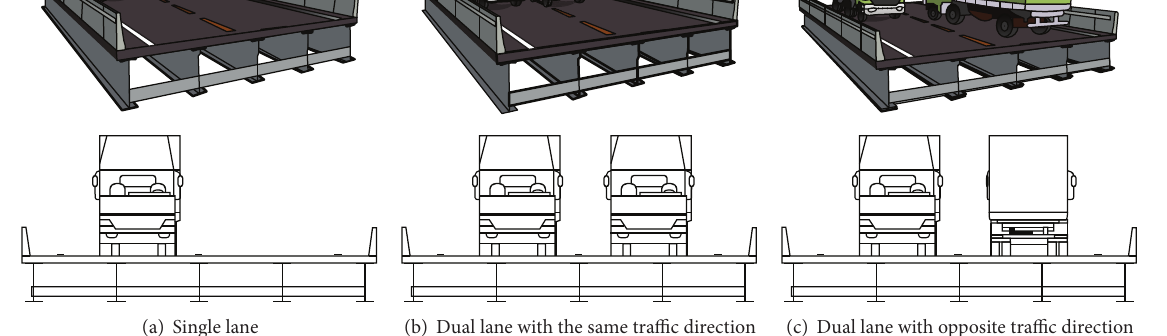
Figure 10: Passing directions of moving trucks.